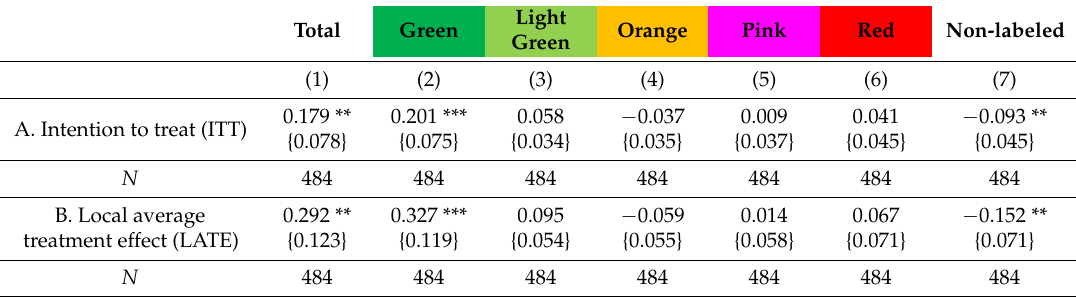
Table 3. ITT and LATE effects of providing Nutri-Score Label information on total expenditure and expenditure by color, using different estimates.